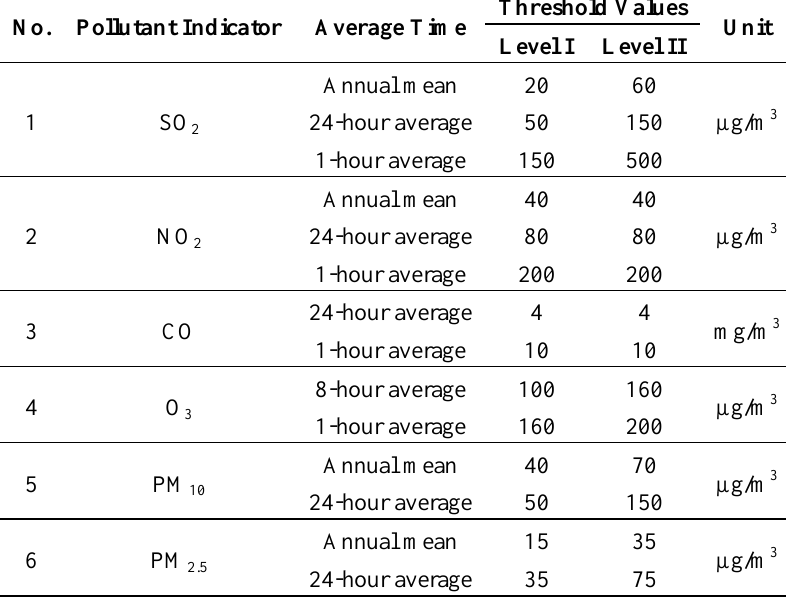
Table 2. Threshold values of ambient air pollutant indicators in GB